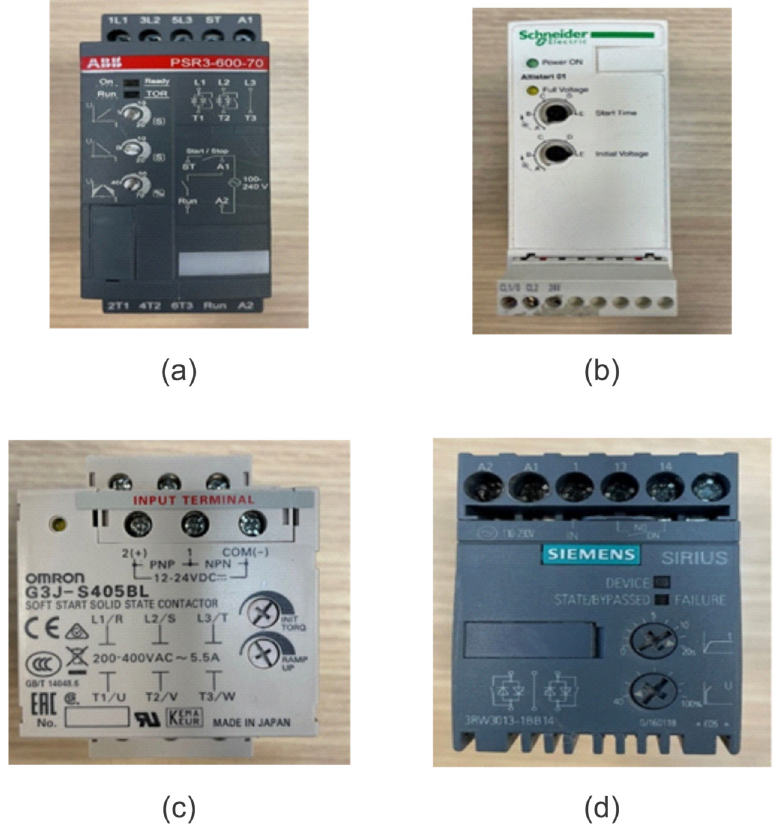
Figure 8. Tested soft-starters. ( a ) ABB PSR3-600-70. ( b ) Schneider. ( c ) Omron G3J-S405BL. ( d ) SIEMENS SIRIUS.